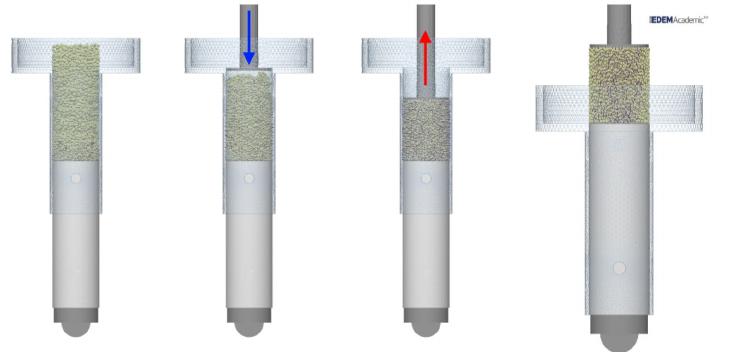
Figure 12. Uniaxial compression showing from left to right: filling, confined loading (consolida- tion), unloading, and unconfined loading as performed by [49]. Reproduced with permission from J. P.